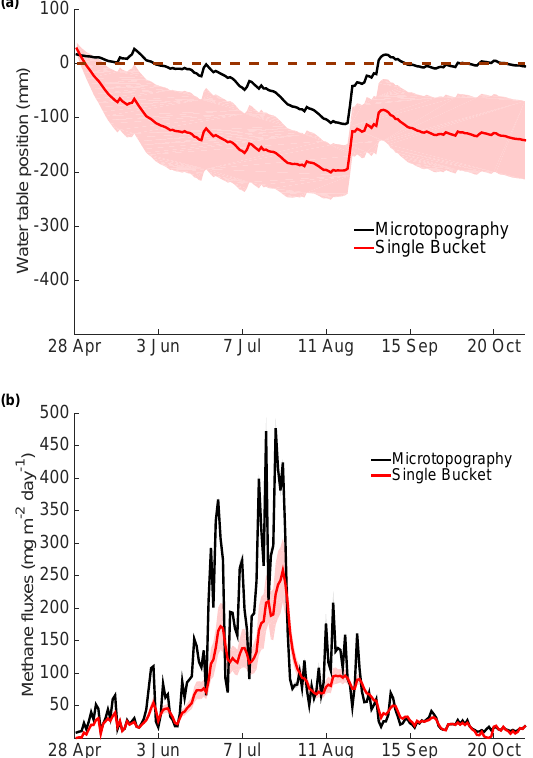
Figure A2. Performances of the HH model in the case of zero slope. In Panel (a) we show the water table dynamics, and in panel (b) the methane emissions. In both panels, black lines are the output of the model in the Microtopography configuration, and the red lines the output of the model in the Single bucket configuration. Shaded areas represent the standard deviation of 30 ensemble